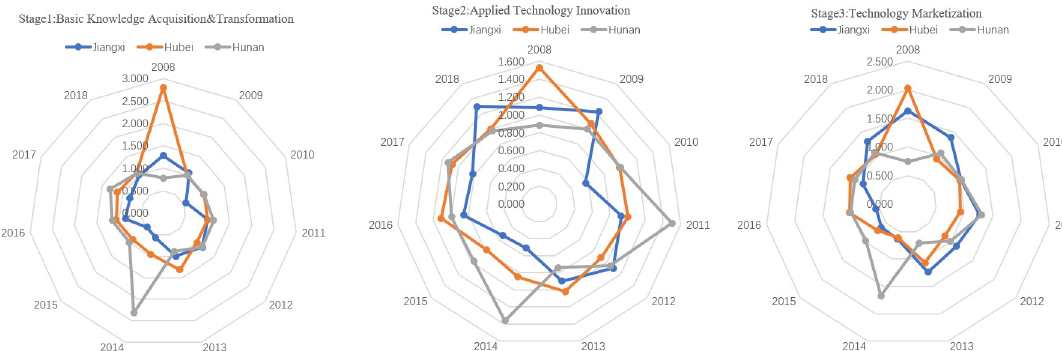
Fig 4. Efficiency of university applied technology innovation stage in Yangtze River Economic Belt.